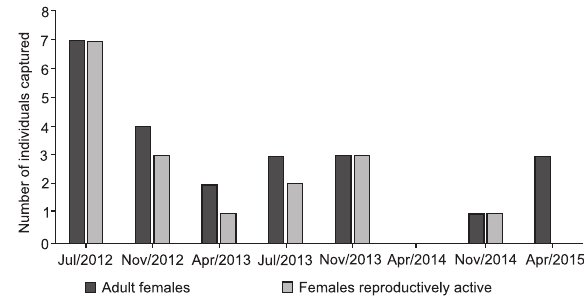
Table 4. Environmental variables loadings on canonical axes after Canonical Correspondence Analysis scores for constraining variables analyzed for the 2012-2015 period in CFMA, Rio de Janeiro, Brazil.